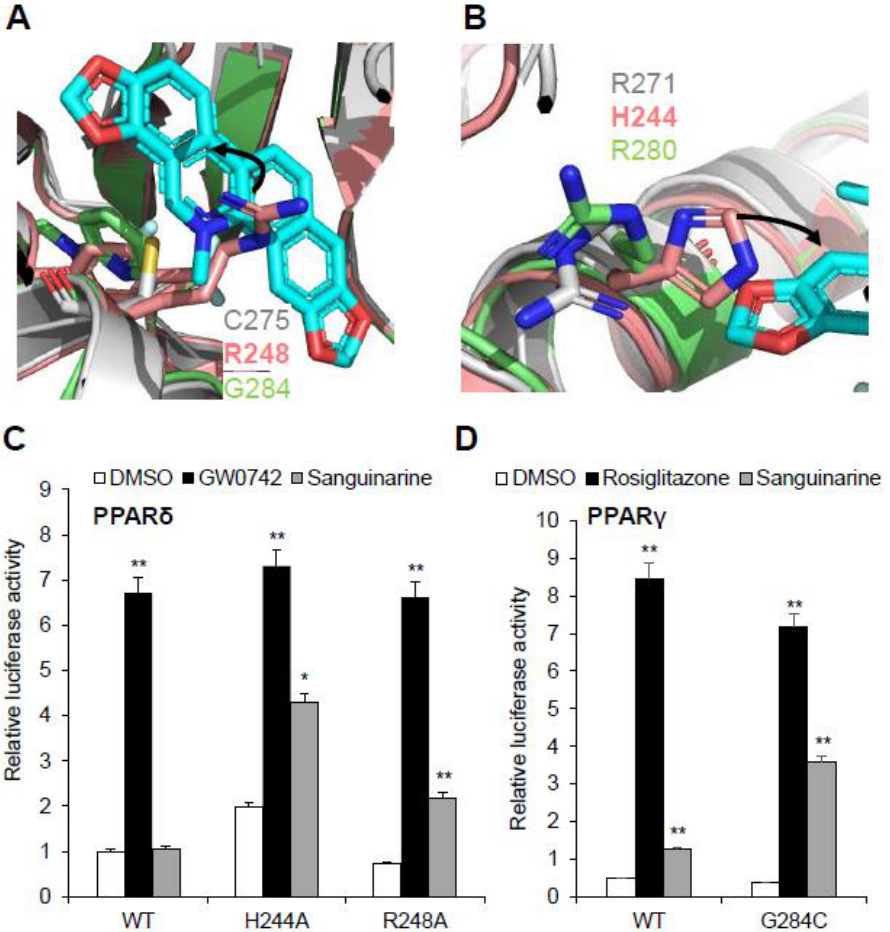
Figure 7. Structural basis of the sanguinarine binding specificity towards all three PPARs. ( A , B ) Superposition of PPAR α –LBD (gray) with PPAR δ –LBD (salmon, PDB code: 3KTM), and PPAR γ –LBD (green, PDB code: 4EMA). Corresponding residues of PPARs are shown in stick representation. The amino acid steric hindrances are shown as curved arrows. ( C , D ) Effects of mutations of key PPARs residues on their transcriptional activity, in response to sanguinarine (black bars) in cell-based reporter gene assays. 293T cells were co-transfected with plasmids encoding full-length PPARs or PPARs mutants, as indicated together with a PPRE luciferase reporter. The cells were treated with 1 µ M sanguinarine, and 1 µ M GW0472 or 1 µ M rosiglitazone, respectively. The results are the average of experiments performed in triplicate, with error bars indicating SDs; * p < 0.05, ** p < 0.01, compared with vehicle.